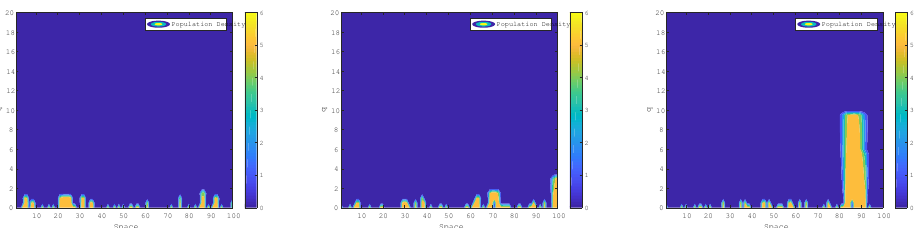
Figure 13. Stationary metapopulation distributions over space as a function of q obtained for the second type initial conditions (16) and (17), β = 6, and three random realizations of the carrying capacity ( left to right ): k ( 1 ) , k ( 2 ) and k ( 3 ) , respectively.